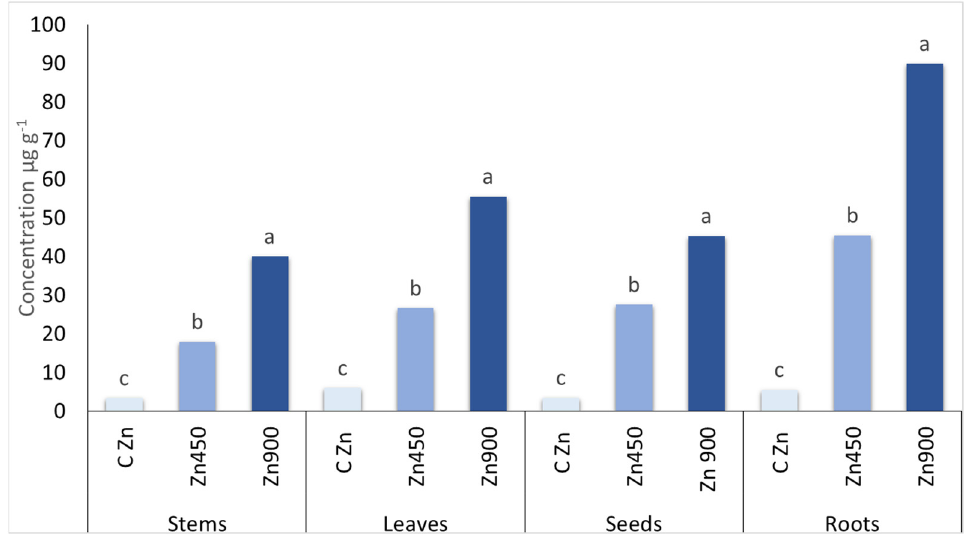
Table 5. Two-way ANOVA of the main factor and interaction for zinc concentration in stems, leaves, seeds, and roots during the two years of the experiment (* significance level at p ≤ 0.05, ** significance level at p ≤ 0.005, *** significance level at p ≤ 0.001).